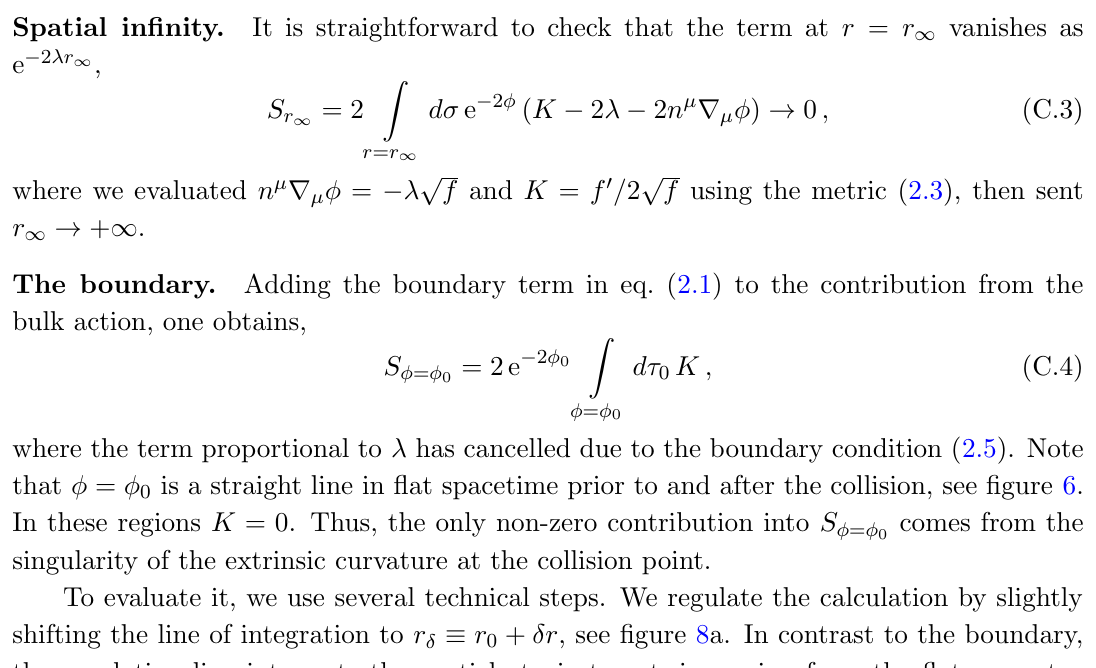
Figure 8 . Regularized boundary r = r (cid:14) in (a) the original coordinates and (b) Gaussian normal frame attached to the